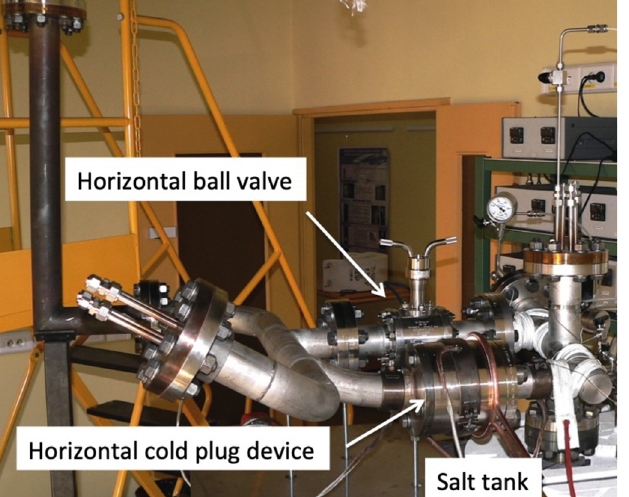
Fig. 6. Second con fi guration for test with the ball valve mounted in parallel.